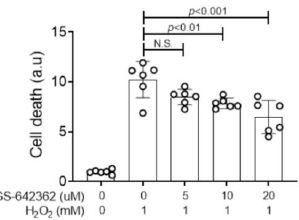
Figure 1. GS-642362 inhibits oxidant-induced cell death. Primary kidney tubular epithelial cells had varying concentrations of GS-642362 added prior to stimulation with 1 mM H 2 O 2 to induce cell death in primary cultures of tubular epithelial cells. Data shows groups of 6 replicate samples. N.S., not